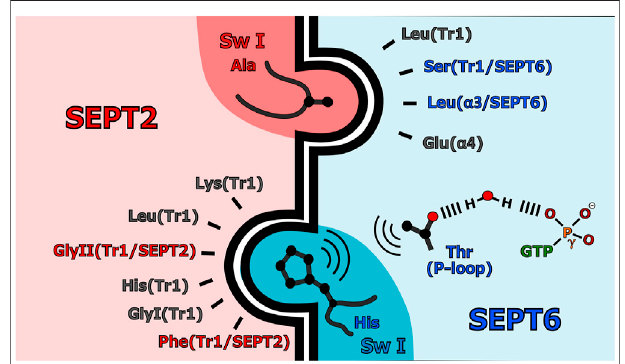
FIGURE 7 | Interaction speci fi cities in the SEPT2-SEPT6 G-interface. Simpli fi ed scheme for the heterotypic interface highlighting the importance of residues coming from switch I on both sides of the interface. Group-speci fi c ( characteristic ) residues are shown colored, in red for SEPT2 and in blue for SEPT6. The network of interactions leading from the interface to the γ -phosphate of the GTP is shown.